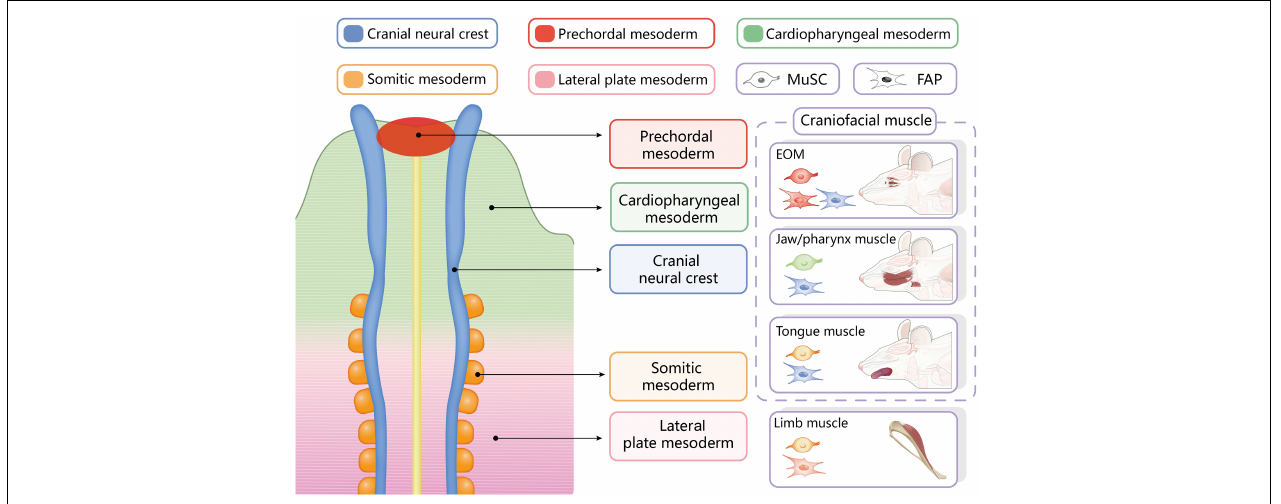
FIGURE 1 | Embryonic origins of resident stem cells in different craniofacial and trunk/limb muscles. EOM, extraocular